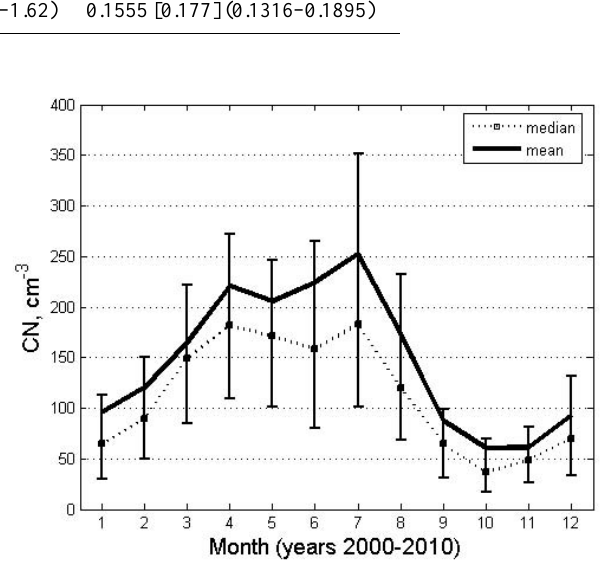
Fig. 5. Annual average variation of median and mean integrated number concentration per month March 2000–March 2010. 25– 75th percentile ranges indicated by vertical “error